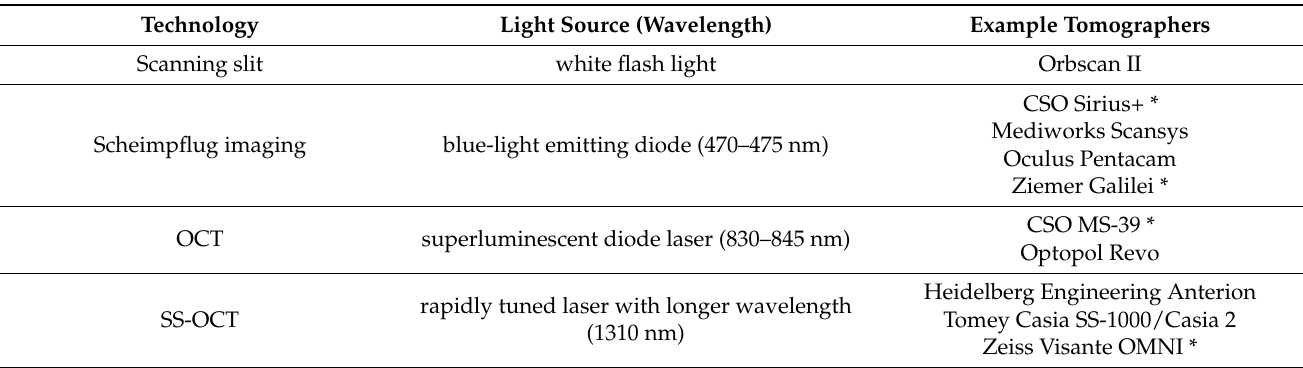
Table 2. Techniques employed for corneal tomography in some of the currently used devices. Technology Light Source